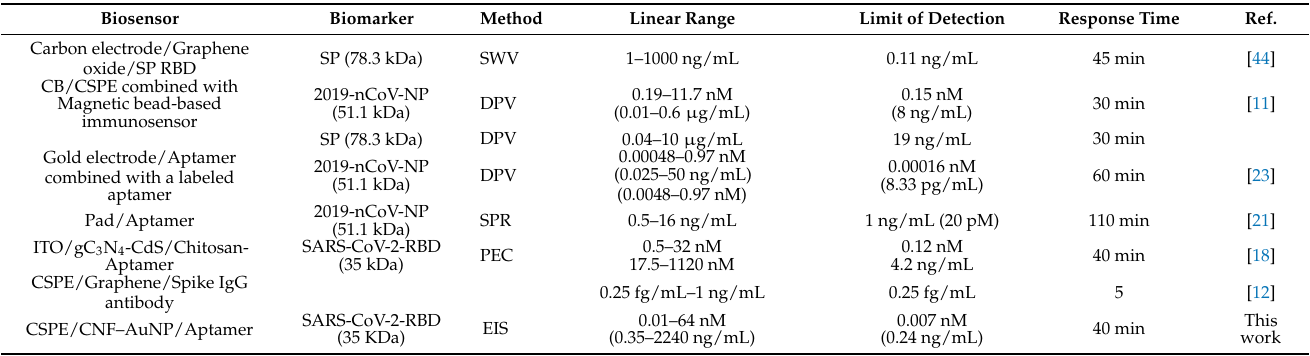
Table 1. Comparison of the analytical performance of the CSPE/CNF–AuNP/Aptamer with the other aptasensors and immunosensors for the biomarkers related to